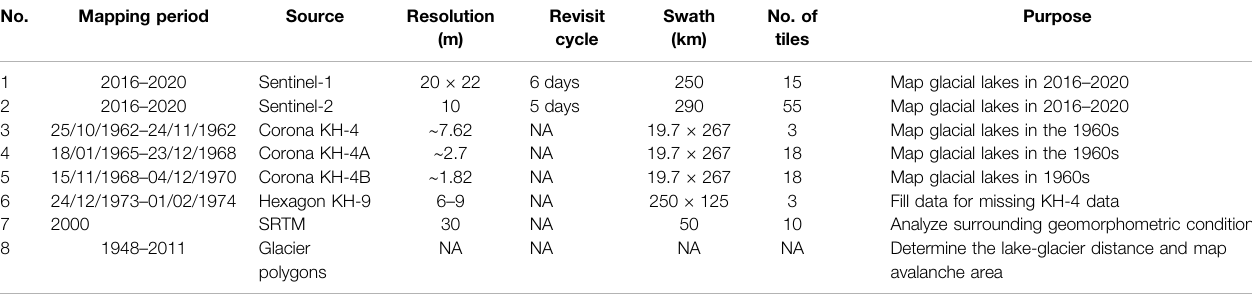
TABLE 1 | Summary of data used for glacial lake mapping and hazard assessment in the Bhutan Himalaya.